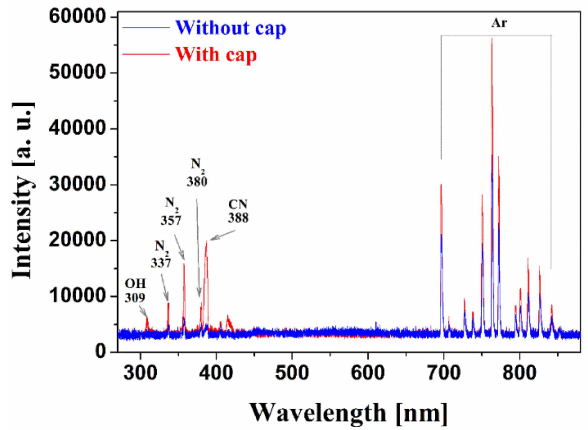
Figure 3. Optical emission spectra measured in the recombination region of iPC-APPJ, with and without the PTFE bottom